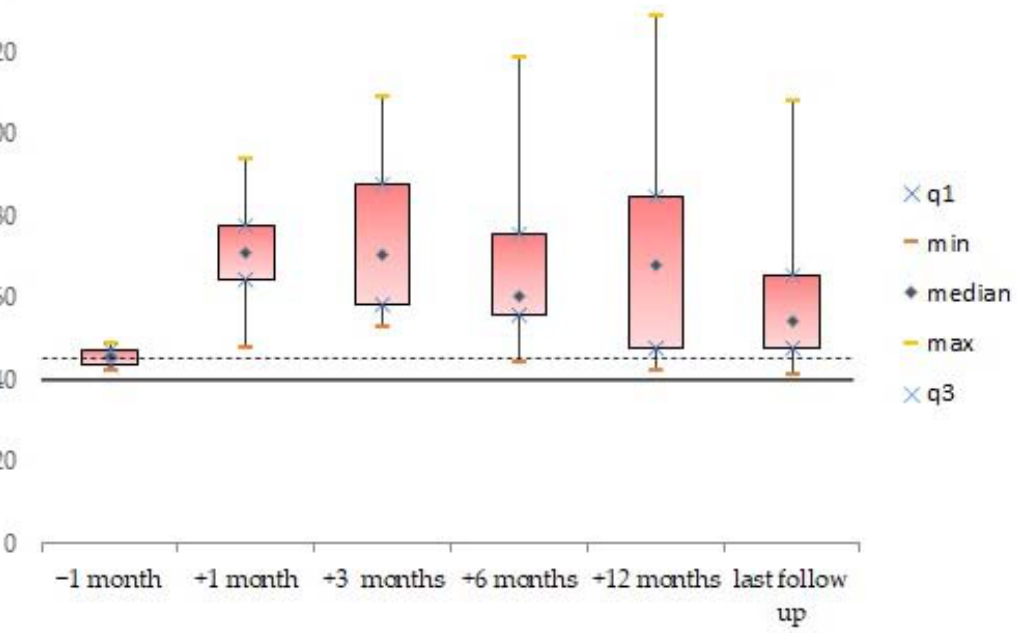
Figure 5. HDL levels before and during vemurafenib. The dashed line indicates the acceptable upper limit, the double line indicates the borderline-high limit according to the NCEP Expert Panel on Cholesterol Levels in Children.